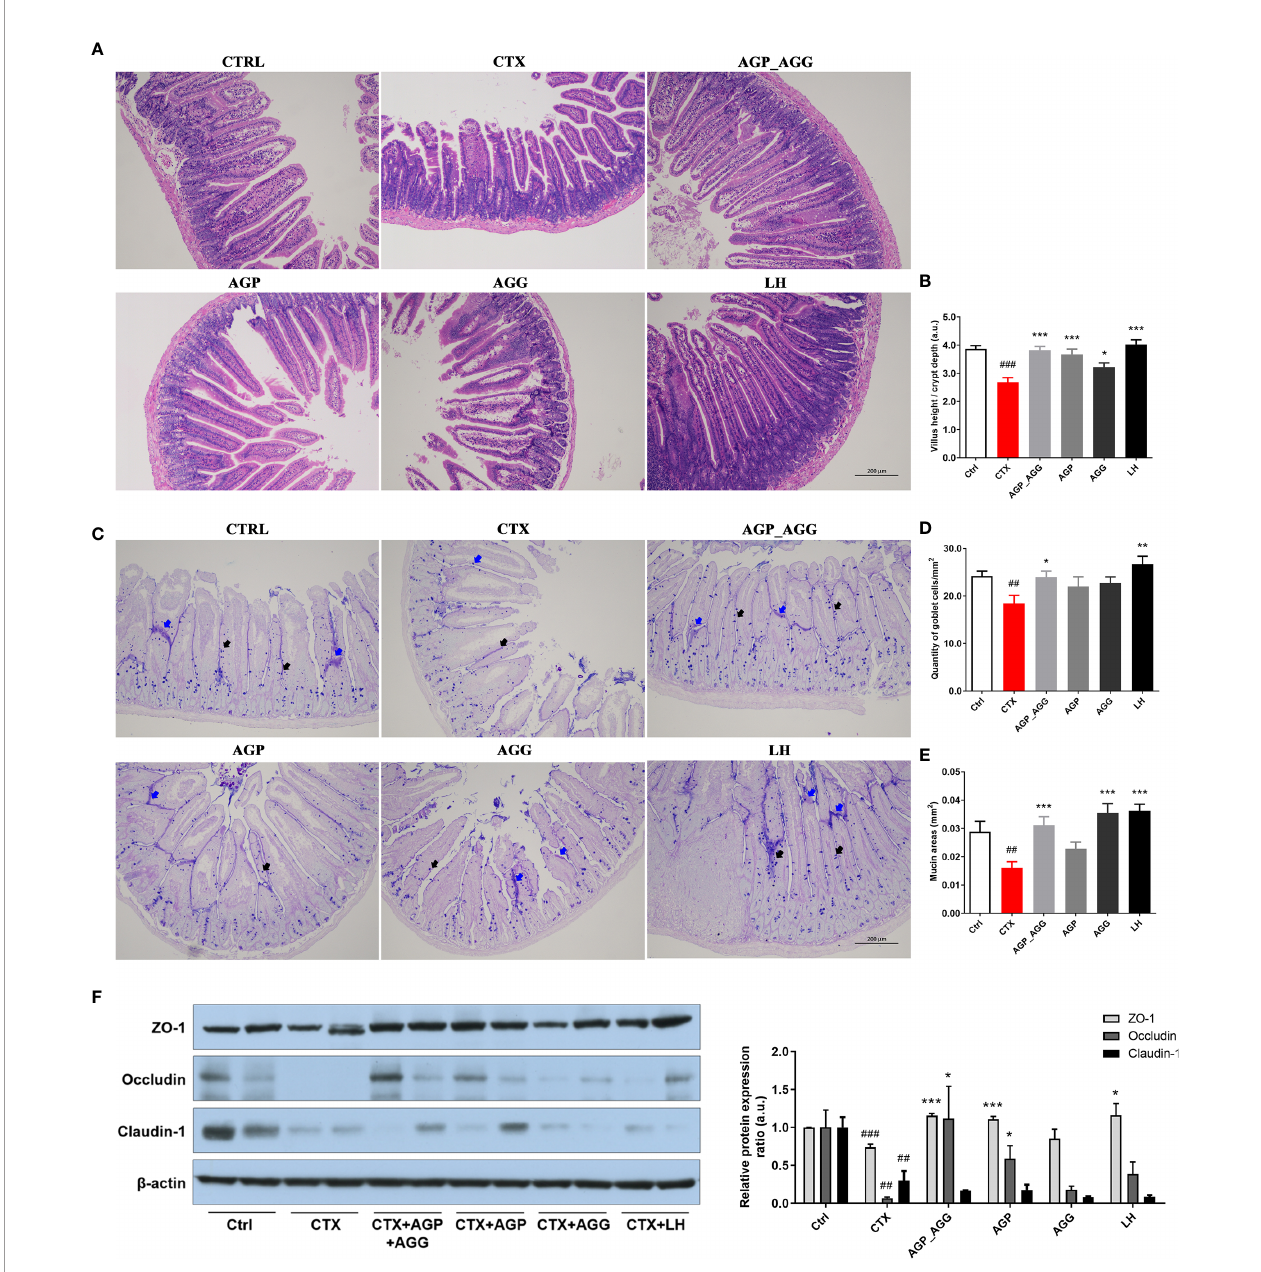
FIGURE 4 | AG treatments alleviated gut barrier disruption in CTX-induced mice. (n=5 for each group). (A) HE staining of jejunum section (100 ×, Scale bar = 200 m m). (B) The ratio of villus height/crypt depth (C) AB-PAS staining of jejunum section. Black arrow represents goblet cells, while blue arrow represents mucins (100 ×, Scale bar = 200 m m). (D) The quantity of goblet cells/mm 2 (E) Mucin areas (mm 2 ). (F) Western blot assay of the protein level of ZO-1, occludin, and claudin- 1 in jejunum section. Data are expressed as mean with SD. ## P < 0.01, ### P < 0.001 compared with Ctrl;* P < 0.05, ** P < 0.01, *** P < 0.001 compared with CTX by student t test. Ctrl, control group; CTX, cyclophosphamide-induced immunosuppressive group; AGP_AGG, American ginseng polysaccharide+American ginseng ginsenoside with cyclophosphamide-induced immunosuppressive group; AGP, American ginseng polysaccharide with cyclophosphamide-induced immunosuppressive group; AGG, American ginseng ginsenoside with cyclophosphamide-induced immunosuppressive